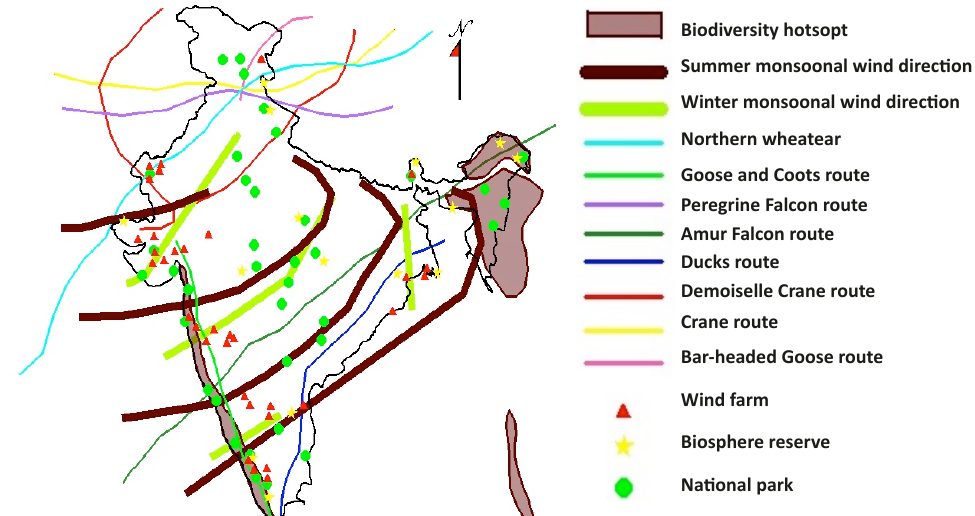
Figure 3. Remote sensing and geographical information system mapping showing the location of biodiversity hotspots, national parks, biosphere reserves, seasonal wind directions, wind farms, and migration rout of some bird species in India (www.microimages.com/products/ tntmips. html).